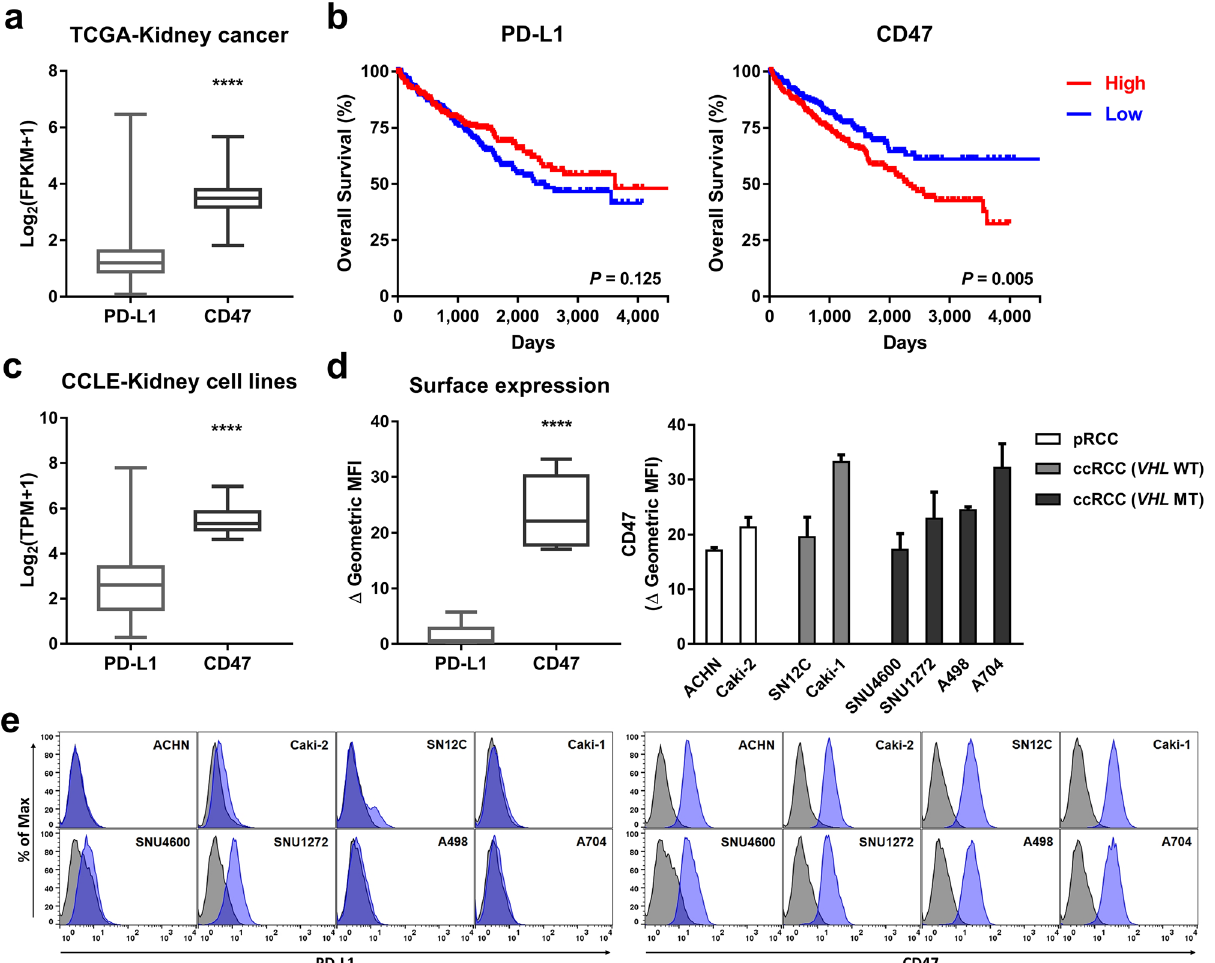
Figure 1. CD47 is highly expressed in renal cell carcinoma (RCC) and is associated with a worse prognosis. ( a ) A comparison of PD-L1 and CD47 expression levels in patients with RCC (n = 1,017) using TCGA data. The box and whisker plot shows the median, minimum, and maximum values. **** P < 0.0001 (two-tailed t test). ( b ) Kaplan–Meier overall survival curves of patients with clear cell RCC (n = 526) according to differential expression (median) of PD-L1 or CD47. Analysis was performed with TCGA data. P values were calculated by log-rank test. ( c ) A comparison of PD-L1 and CD47 mRNA expression levels in human RCC cell lines (n = 31) using CCLE data. The box and whisker plot shows the median, minimum, and maximum values. **** P < 0.0001 (two-tailed t test). ( d ) A comparison of surface PD-L1 and CD47 expression levels in human renal cell carcinoma cell lines (n = 8) analyzed by flow cytometry. Box and whisker plot (left) shows the mean, minimum, and maximum values in all RCC cell lines. Bar graph (right) represents Δ geometric mean fluorescence intensity (MFI) ± SD of each RCC cell line averaged from three independent experiments. The Δ geometric MFI was calculated by subtracting the MFI of stained cells with isotype control from the MFI of cells stained with the antibody. ( e ) Representative histogram indicating ‘ d’ shows isotype control (gray-filled) and staining (blue- filled) with anti-PD-L1 antibody (left) or anti-CD47 antibody